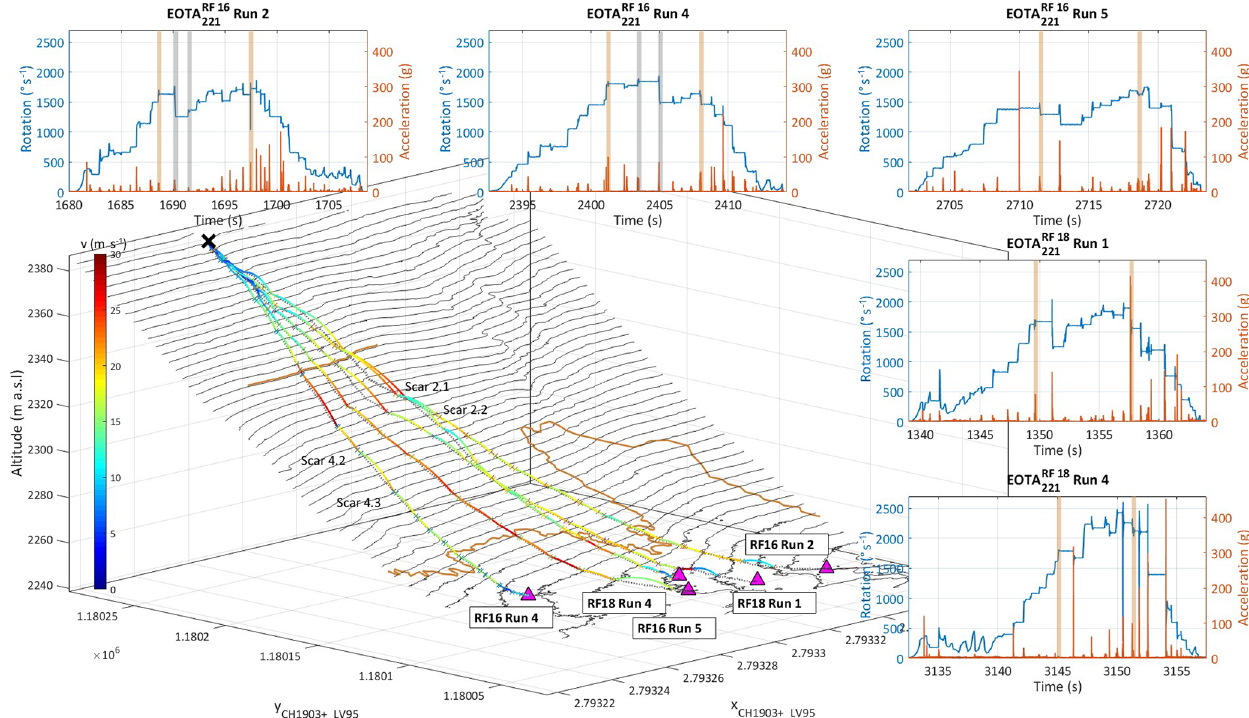
Figure 3. Four-dimensional trajectory reconstruction of five selected experimental runs. The trajectory is colour-coded based on its transla- tional resultant velocity, where the top speeds of roughly 30ms − 1 are usually reached after the longest airborne phase at the cliff jump. The level of the cliff and the transition to the scree field are outlined. The insets show the corresponding in situ sensor streams featuring resultant impact accelerations and angular velocities. The sections corresponding to the start of the cliff jump and the entrance into the scree field are shaded in orange in the sensor data plots. For RF16 Run 2 and RF16 Run 4, the investigated scars are shaded